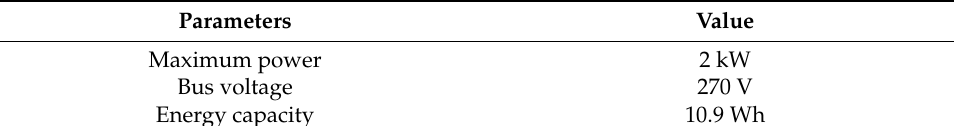
Table 1. SC-ESS Targeted Specifications.